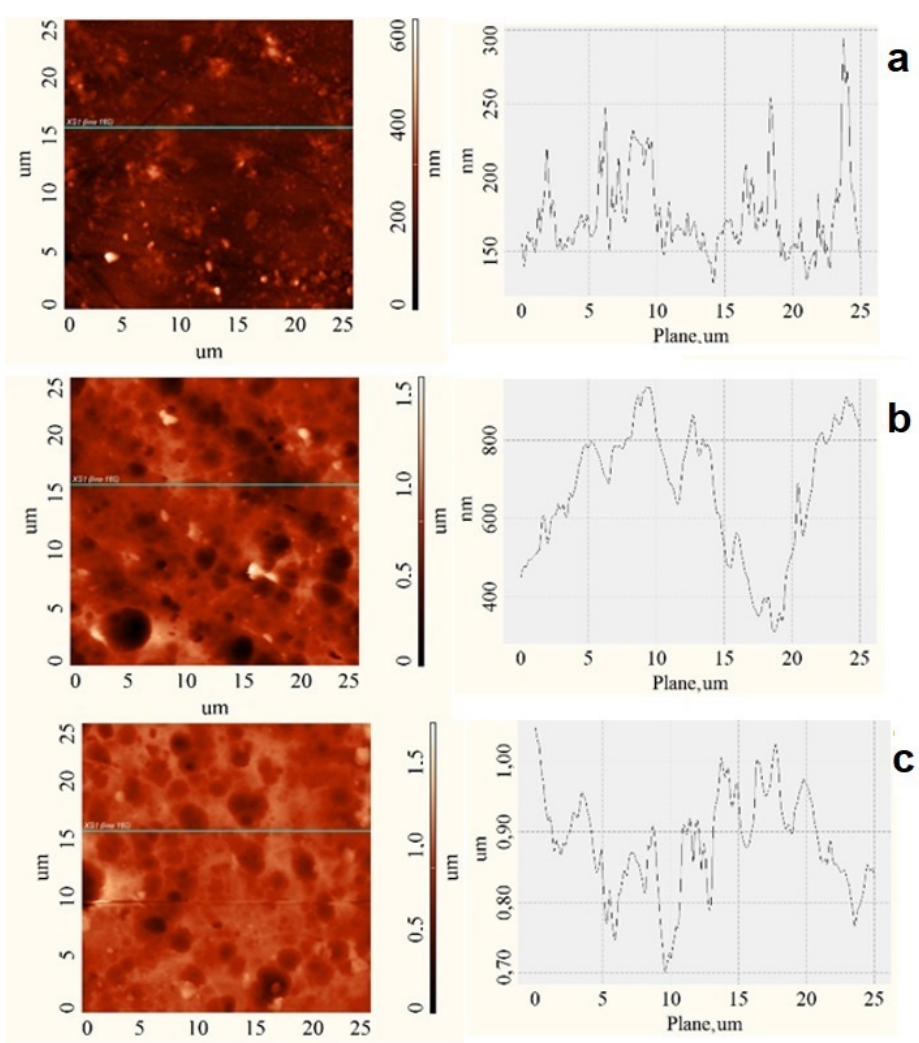
Figure 2. Photographs of the surface and profile diagrams of AMg6 alloy after degreasing ( a ), etching ( b ), and hydrophobization ( c ) stages [19].